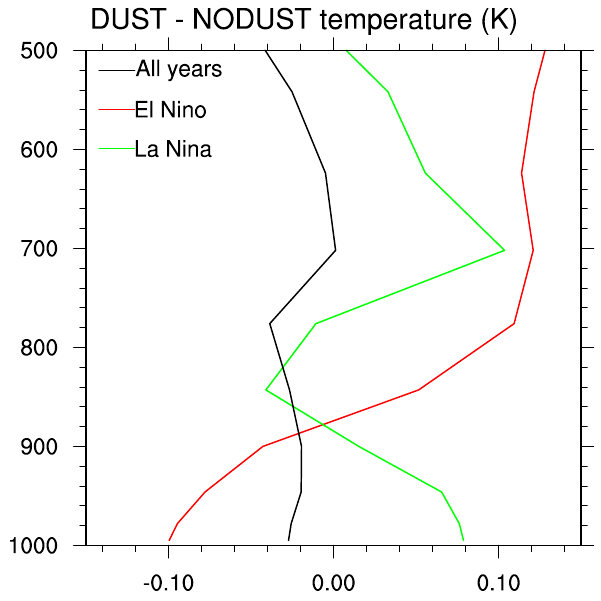
Fig. 15. As Fig. 14, but showing profiles of dust-induced temper- ature changes (difference between the DUST and NODUST runs). The dust-induced SST change is plotted at